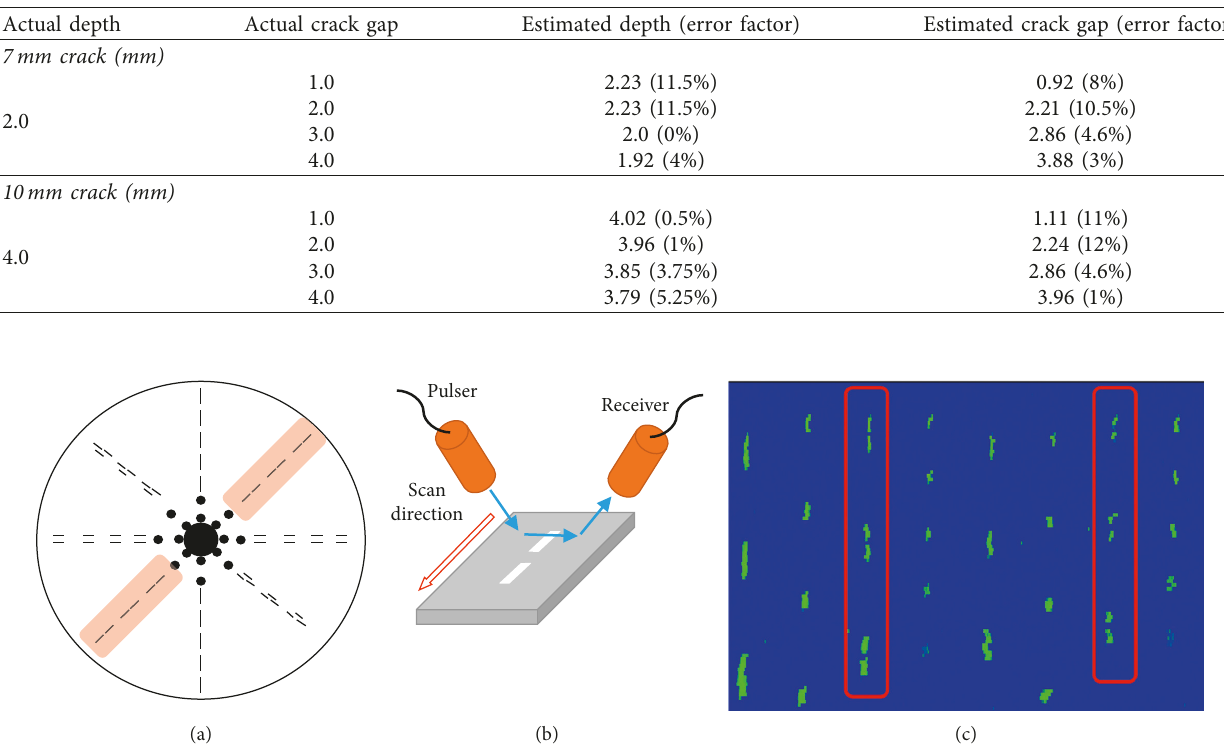
Figure 18: Experimental setup of V-double type crack: (a) crack location, (b) experiment, and (c) C-scan